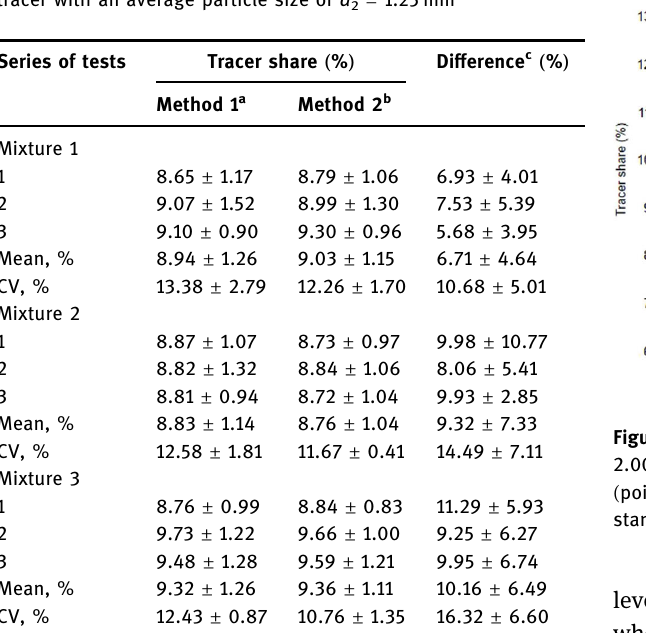
Table 3: Results of mixing of compound feed for cattle using a tracer with an average particle size of d 2 = 1.25 mm